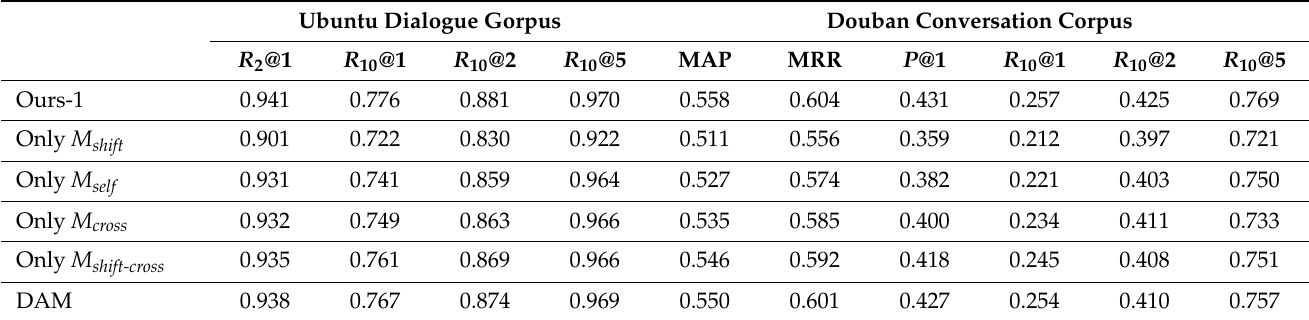
Table 8. The results of the ablation experiment for the two proposed